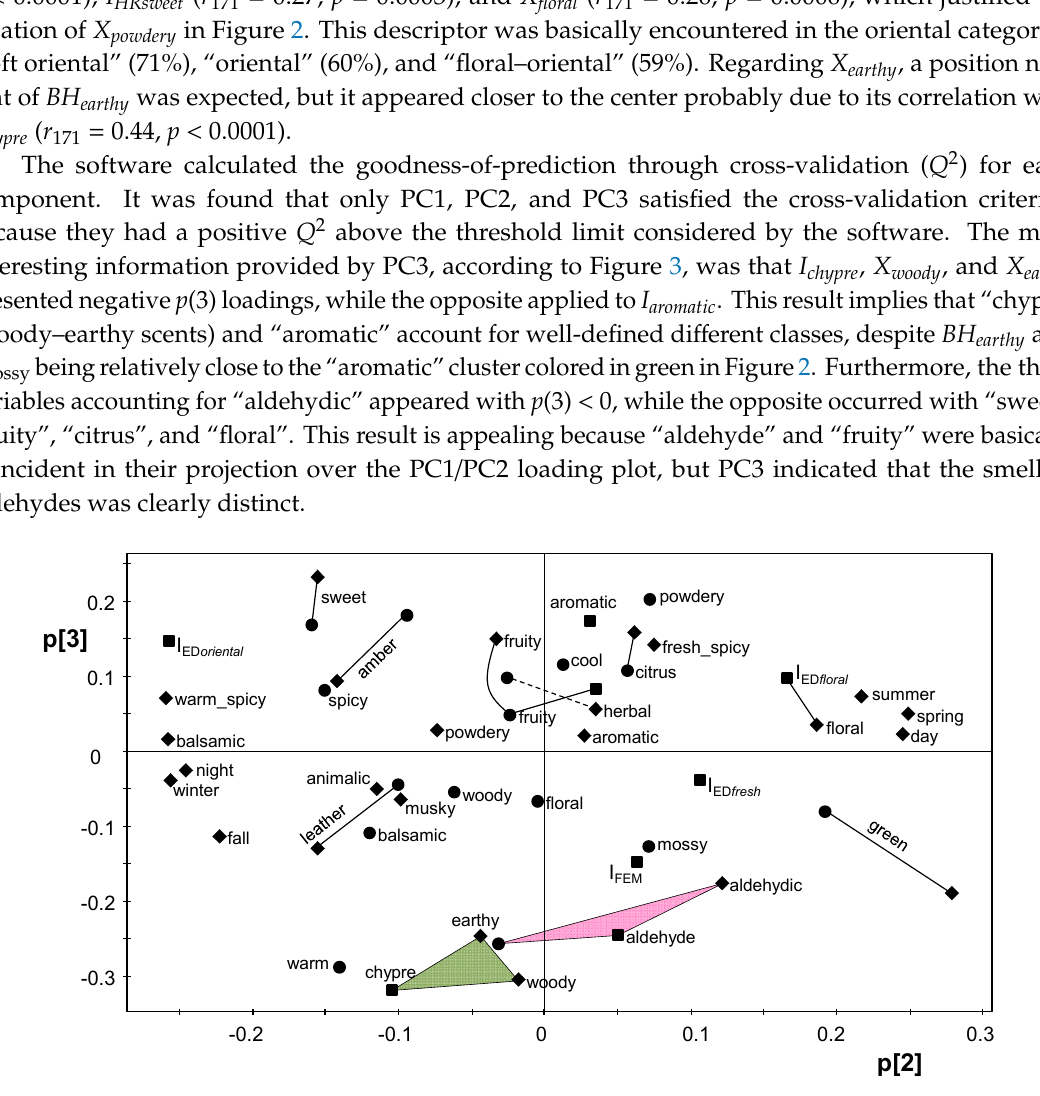
Figure 3. Loading plot ( p (3) vs. p (2)) of the PCA applied to olfactory profiles (48 variables) obtained for the set of 176 perfumes (see Table 1 for list of variables included and point codes). Some equivalent odor descriptors are joined with lines. The green polygon highlights that “chypre” accounts for earthy–woody scents.